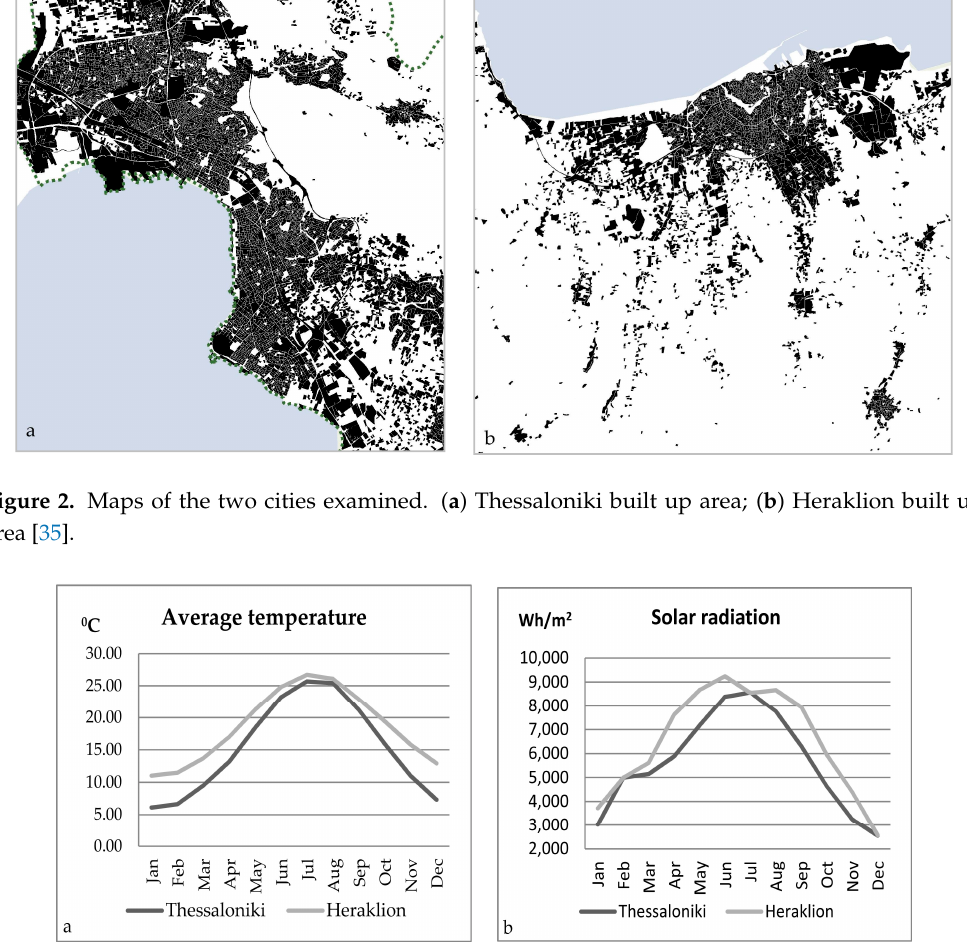
Figure 3. Climate data for the two cities. ( a ) Monthly average temperature of the two cities in °C; ( b ) Monthly distribution of solar radiation in Wh/m 2 . Data source: [36].